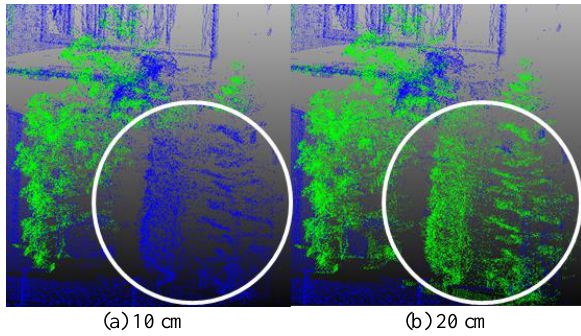
Figure 8. Difference of results extracted with different sizes of voxels (blue: vegetation; green: non-vegetation.)